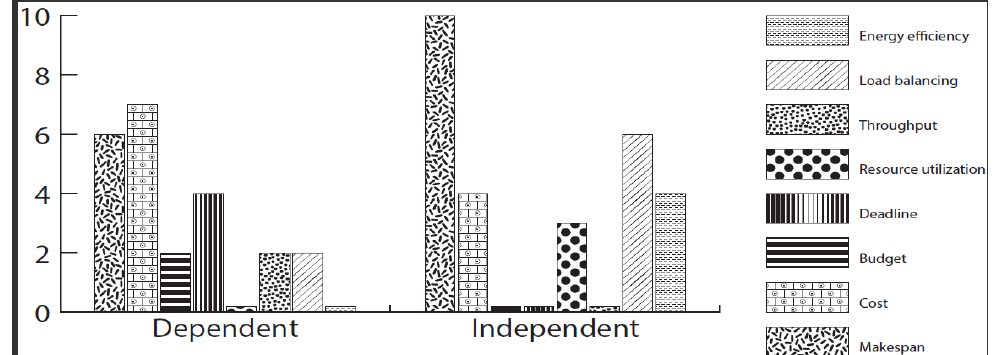
Figure 7. Optimization criteria considered in meta-heuristic